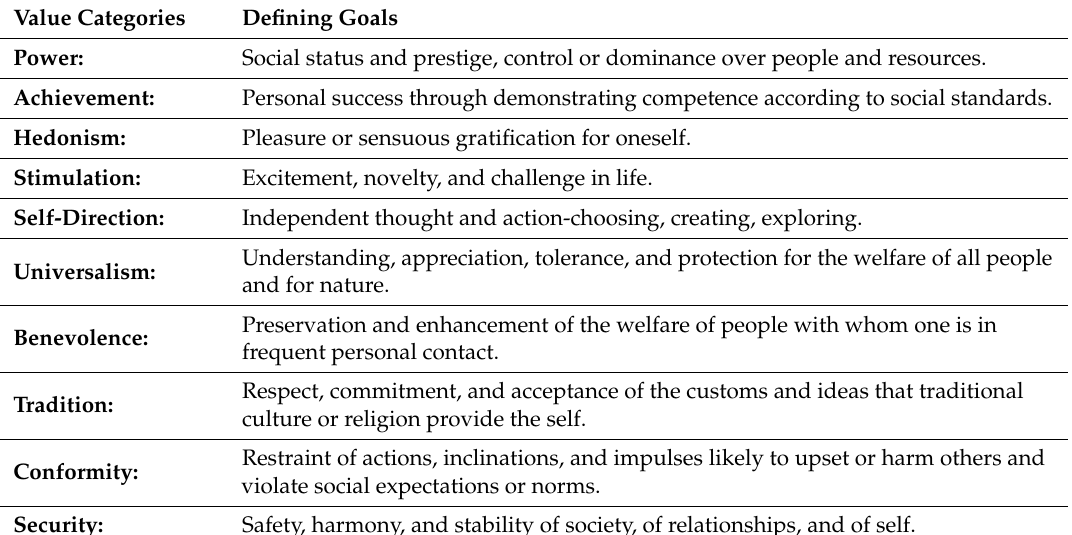
Table 1. Value categories and their defining goals (Schwartz 1992).